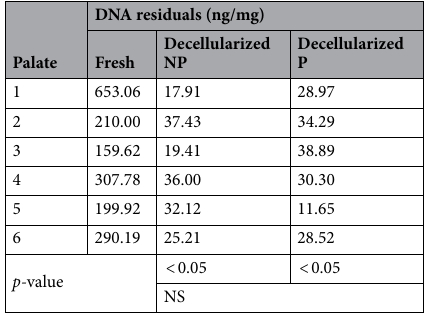
Table 1. DNA quantification in fresh and decellularized